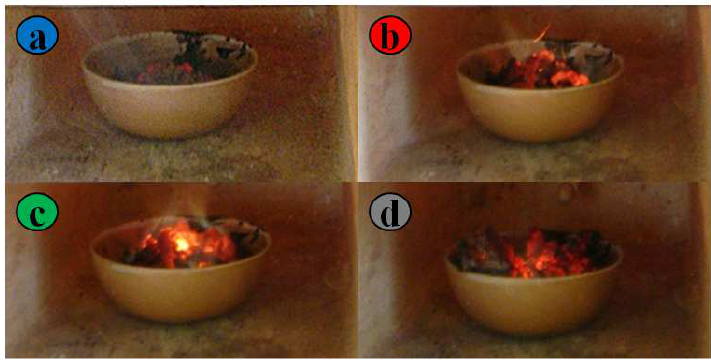
Figure 1. ( a ) Viscous sol into the furnace; ( b ) preliminary combustion; ( c ) propagation of flames in the sol overall volume; ( d ) end of gel combustion